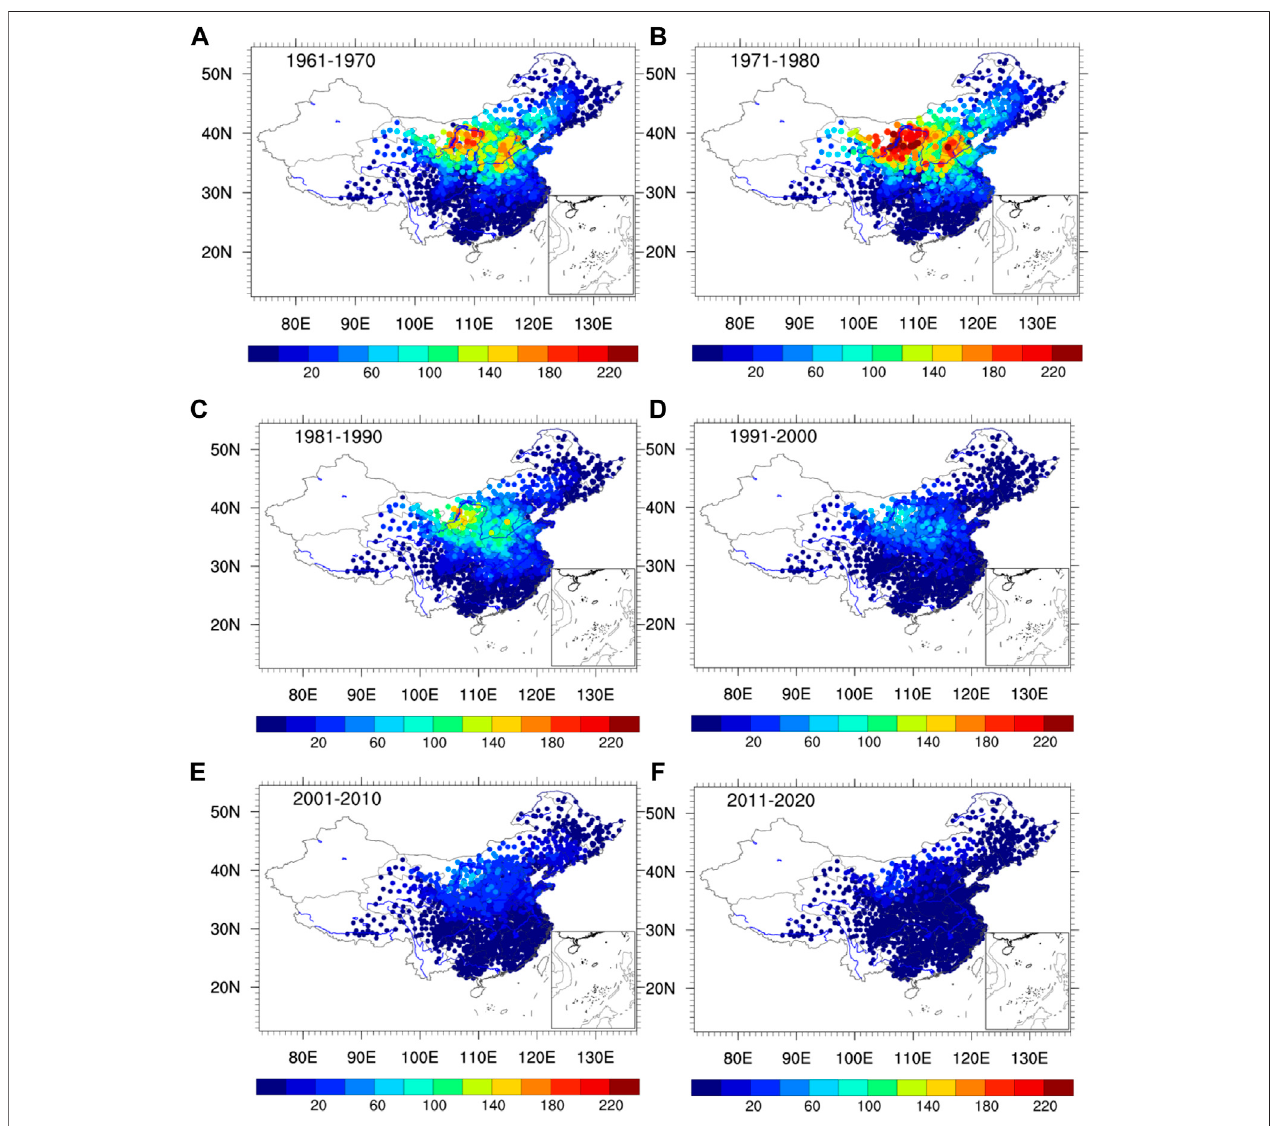
FIGURE 14 | The spatial distribution map of the number of sand-dust processes participated by each station in each decade in China from 1961 to 2020.